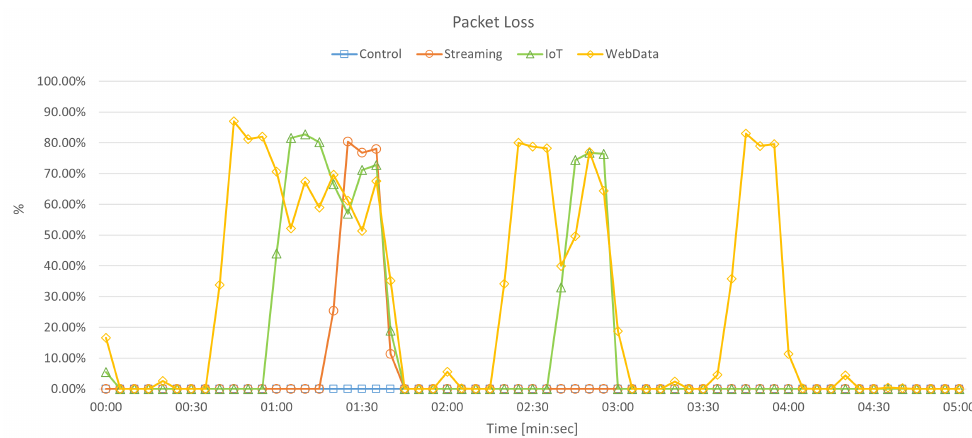
Figure 11. Packet loss obtained from the scenario using the second